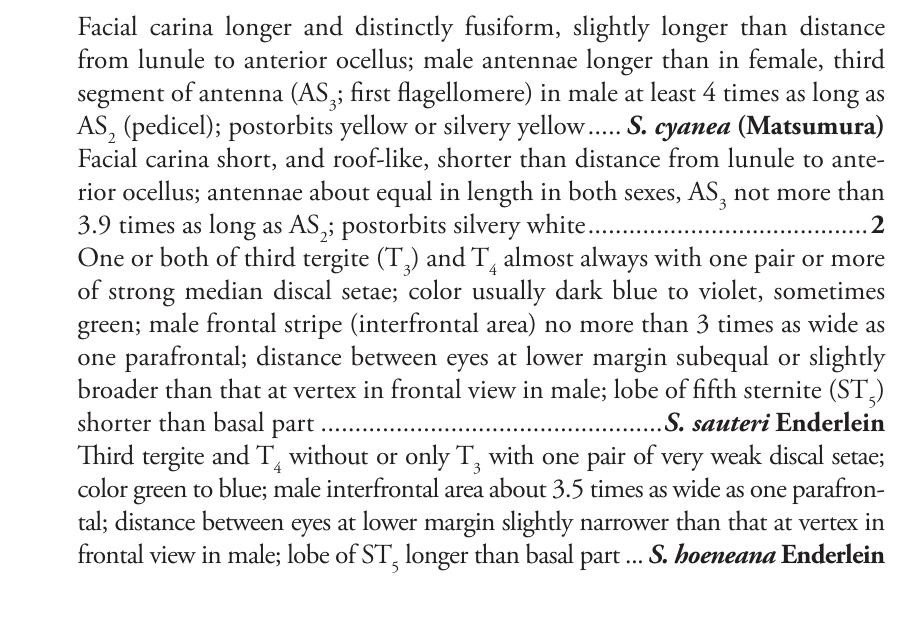
Tribe Catapicephalini